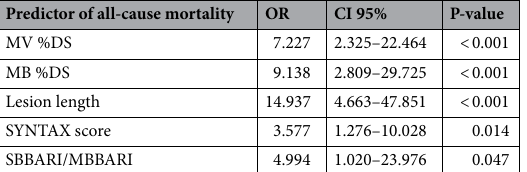
Table 2. Independent predictors of functionally significant bifurcation stenosis (FFR ≤ 0.80) on multivariate